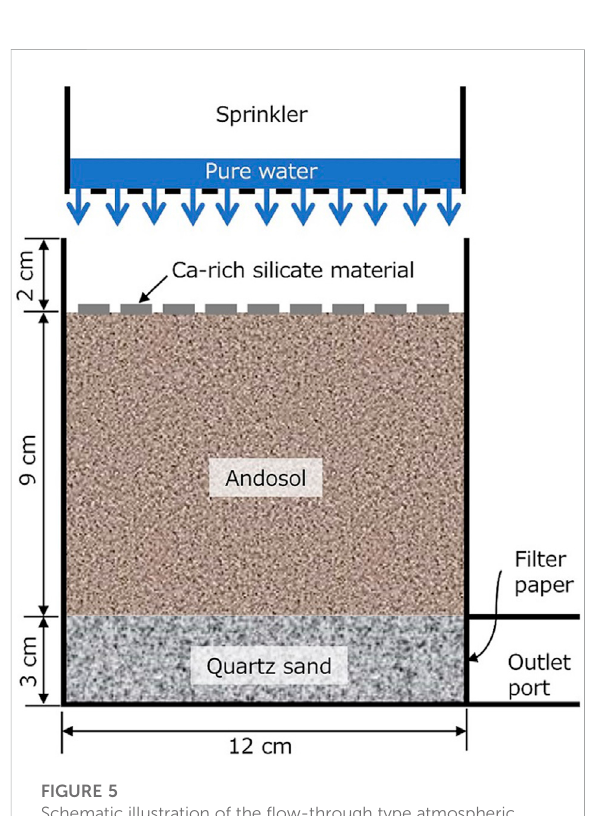
FIGURE 5 Schematic illustration of the fl ow-through type atmospheric CO 2 removal experiment conducted in this